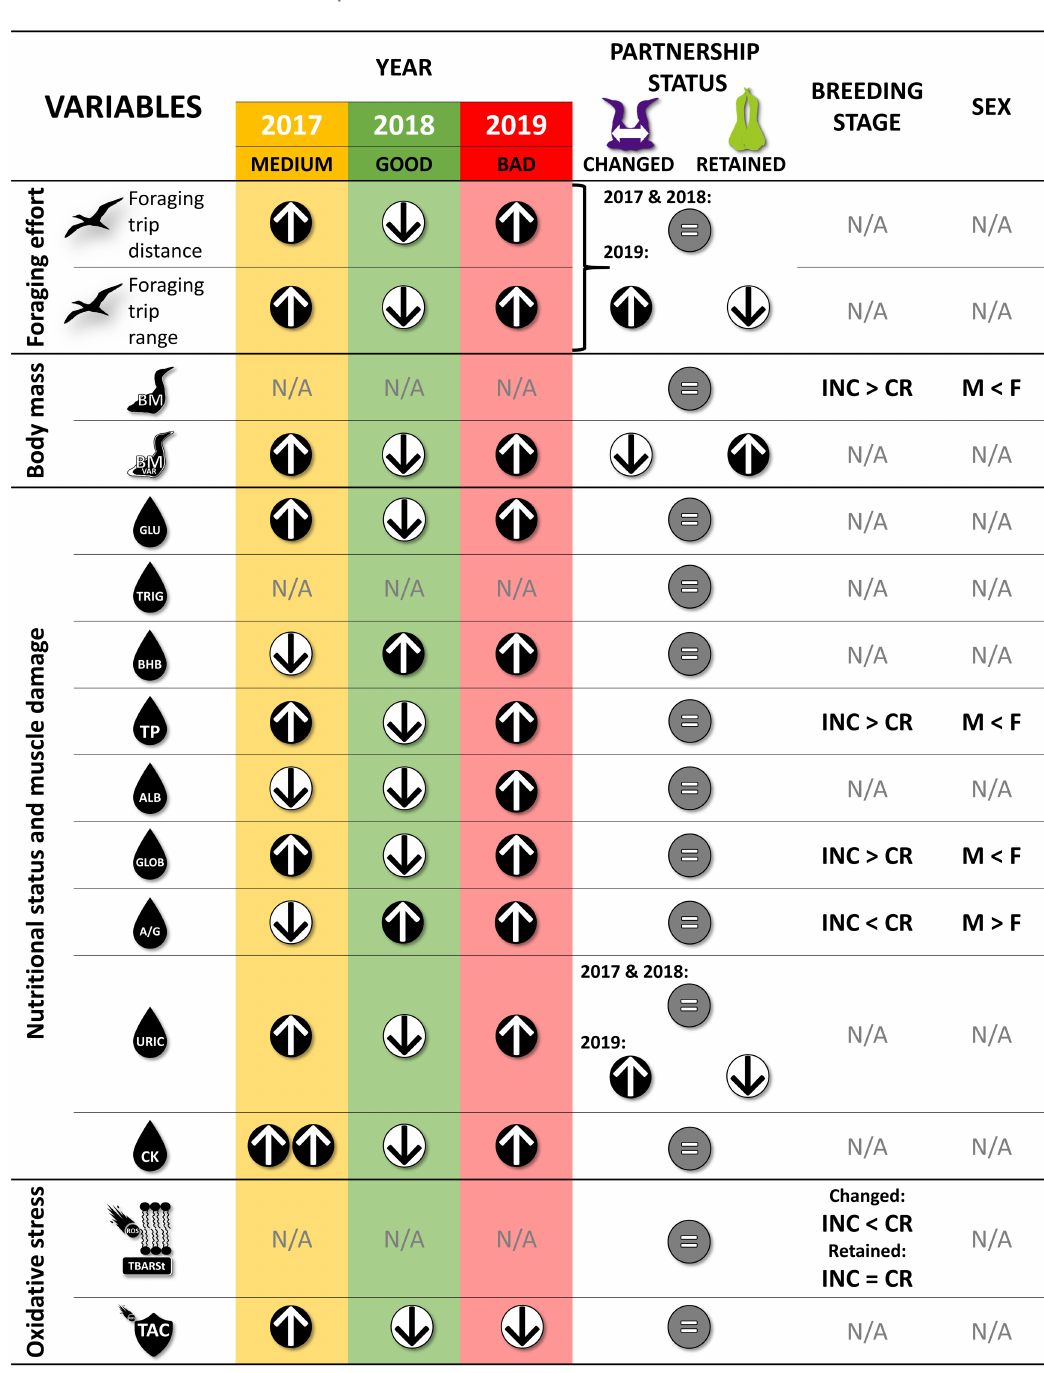
TABLE 2 Summary of the most parsimonious linear mixed models including partnership status calculated for behavioral and physiological variables (parental foraging effort, body mass, nutritional status, muscle damage, oxidative stress) with year, partnership status, breeding stage, sex, and interactions as fixed factors, and bird ID as random